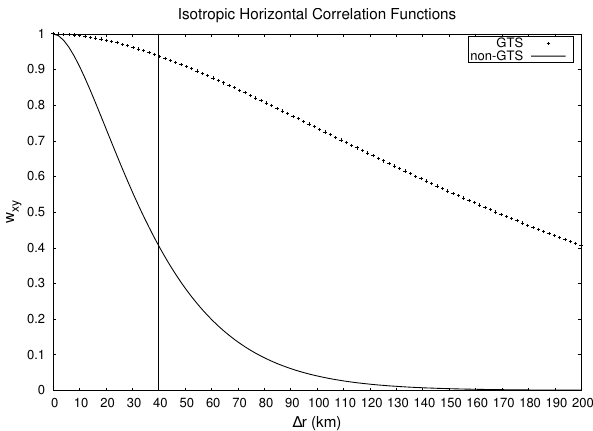
Fig. 4. Isotropic horizontal correlation functions in case of non-GTS data (continuous line) and GTS data (dotted line). The former is truncated at 40 km and the latter at 200 km.